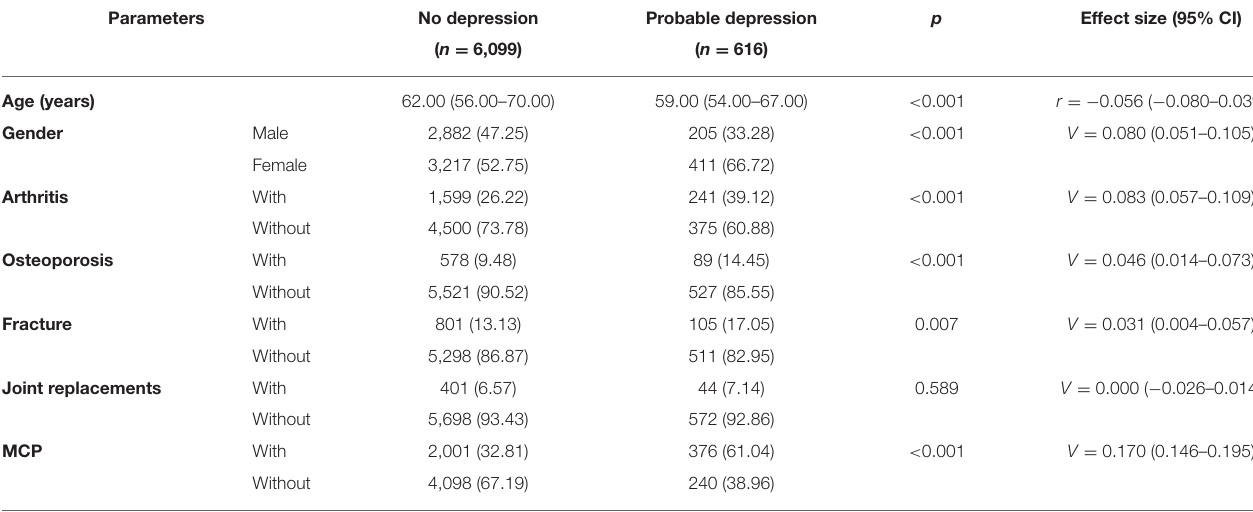
TABLE 1 | Demographics of Irish participants aged 50 and above on